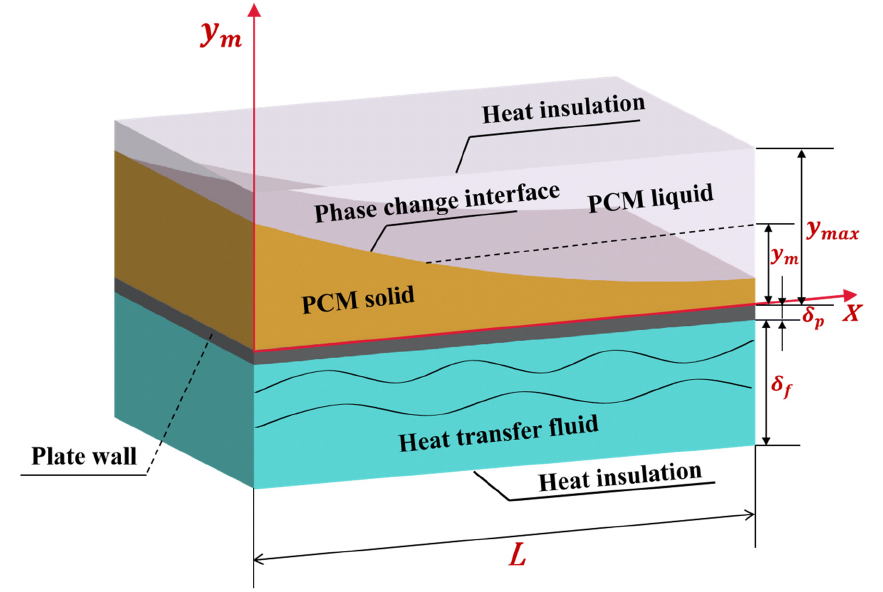
Figure 2. Mathematical model of phase change heat storage